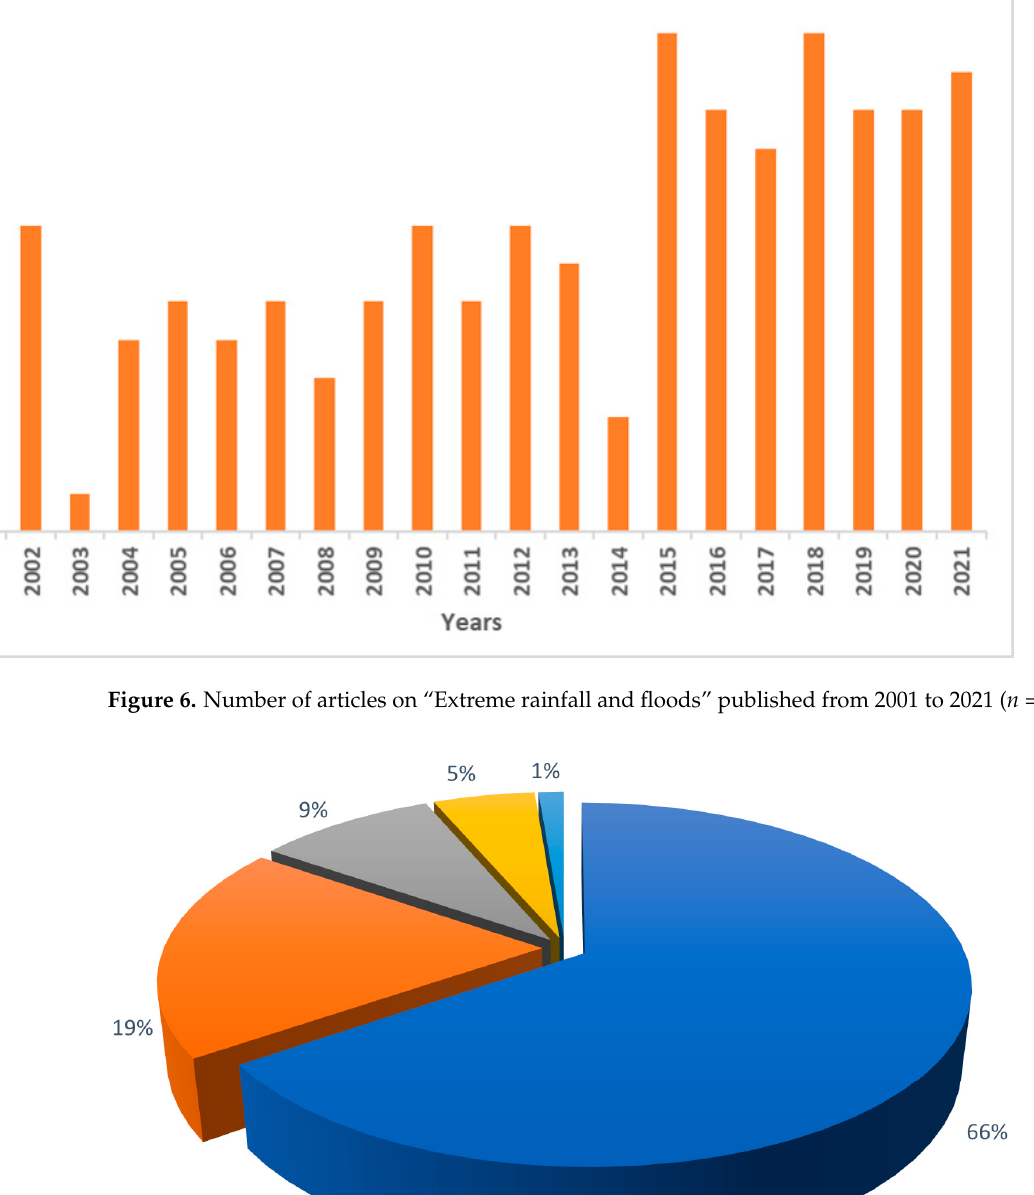
Figure 7. Percentage of all “Extreme rainfall and floods” articles grouped by their geographical dis- tribution.